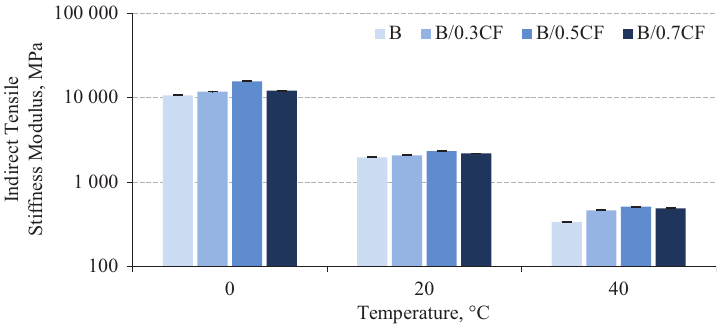
Figure 3. Indirect Tensile Stiffness Modulus values of the control and carbon fibre asphalt mixtures